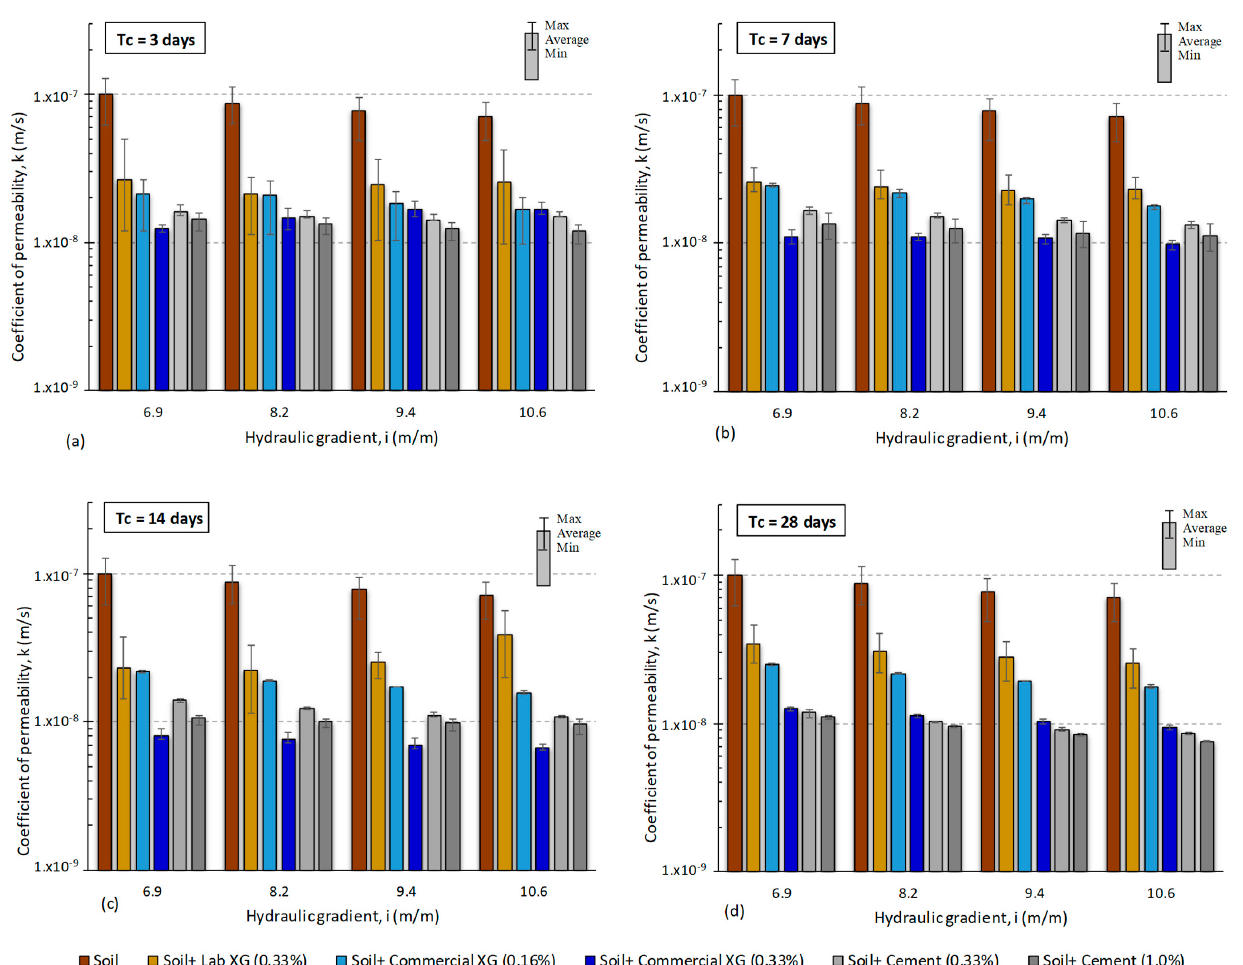
Figure 4. Permeability coefficient of the natural soil and stabilised soil for different hydraulic gradients; ( a ) curing time of 3 days; ( b ) curing time of 7 days; ( c ) curing time of 14 days; ( d ) curing time of 28 days.